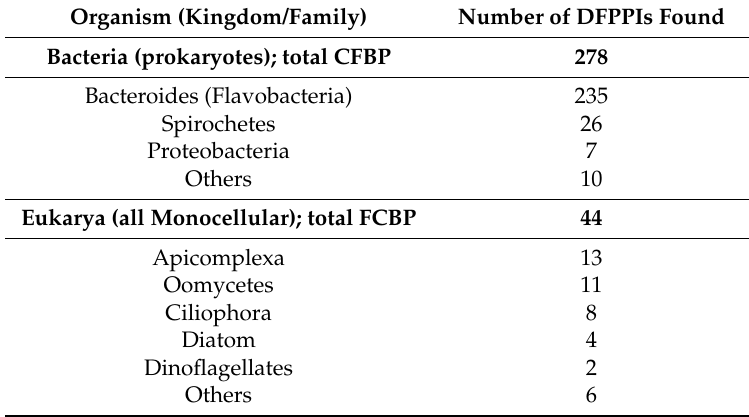
Table 1. List of organism families containing dual-family peptidylprolyl isomerase (DFPPI) genes 1 . Organism (Kingdom/Family) Number of DFPPIs Found Bacteria (prokaryotes); total CFBP 278 Bacteroides (Flavobacteria) 235 Spirochetes 26 Proteobacteria 7